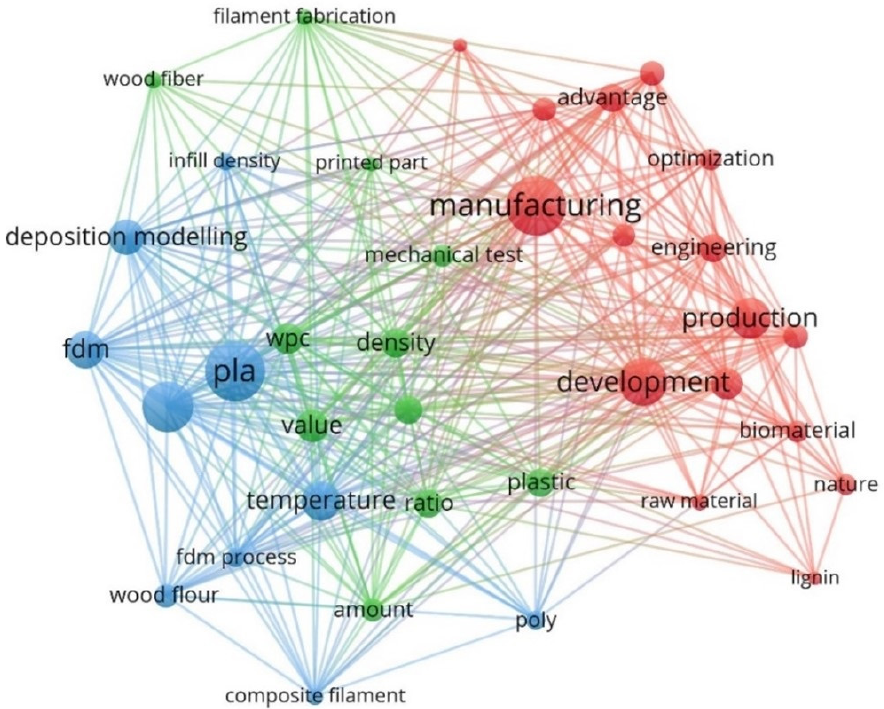
Figure 2. The terms that appeared most from searches concerning our topic in the Scopus database-terms visualization network from VOSviewer v1.6.18 software.